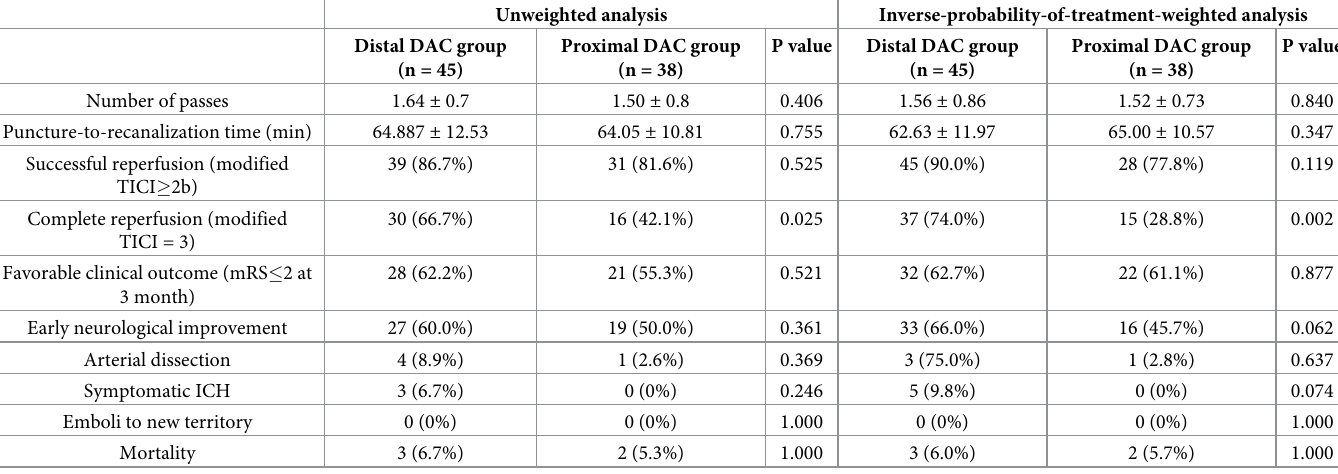
Table 2. Comparison of the outcomes between the distal and proximal DAC